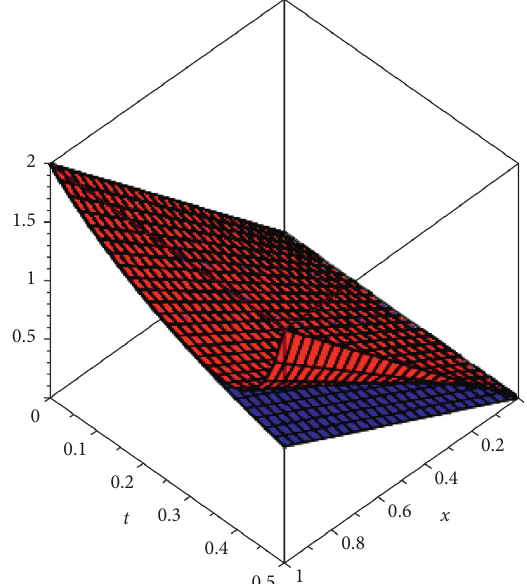
Figure 3: Comparison of the exact solution (blue) and the ap- proximate solutions (red) of Example 3.